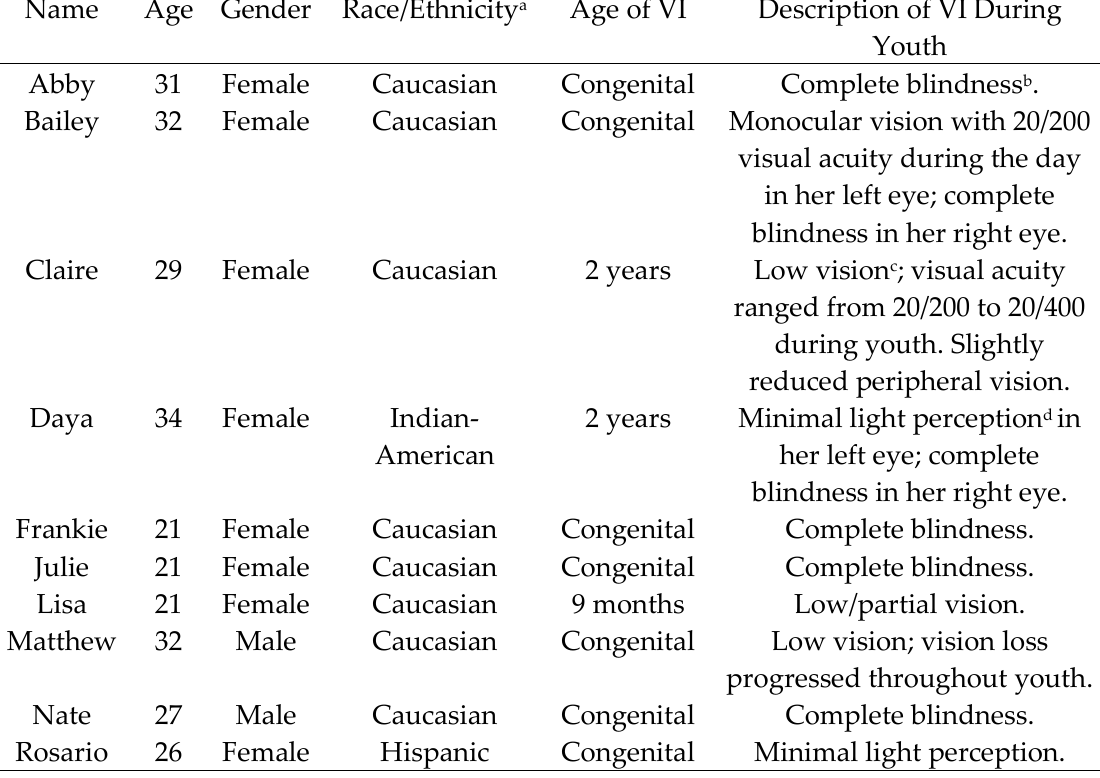
Table 1. Demographic descriptors of